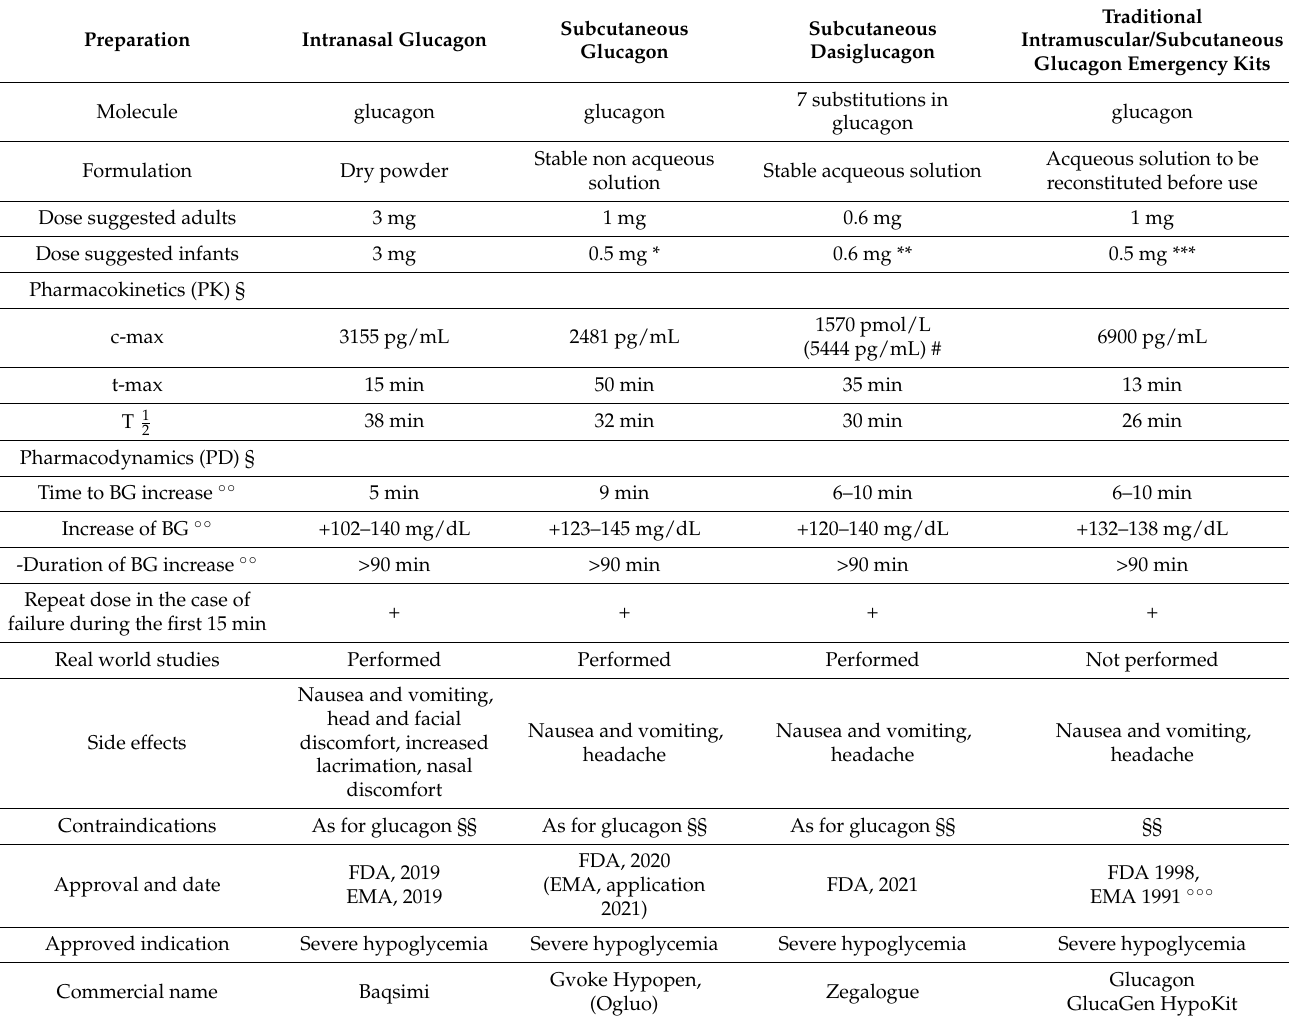
Table 1. New ready-to-use glucagon preparations approved for treatment of severe hypoglycemia, compared to traditional emergency